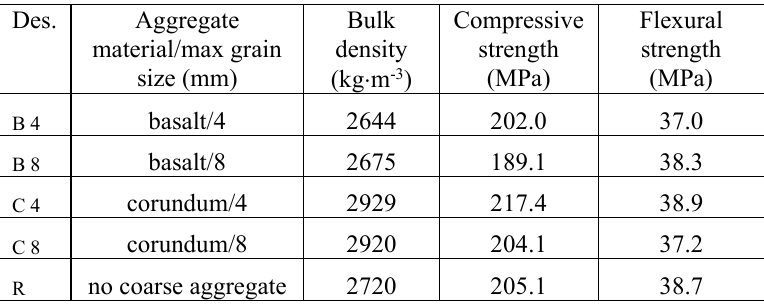
Table 1. Physico-mechanical properties of the tested UHPFRC mixtures